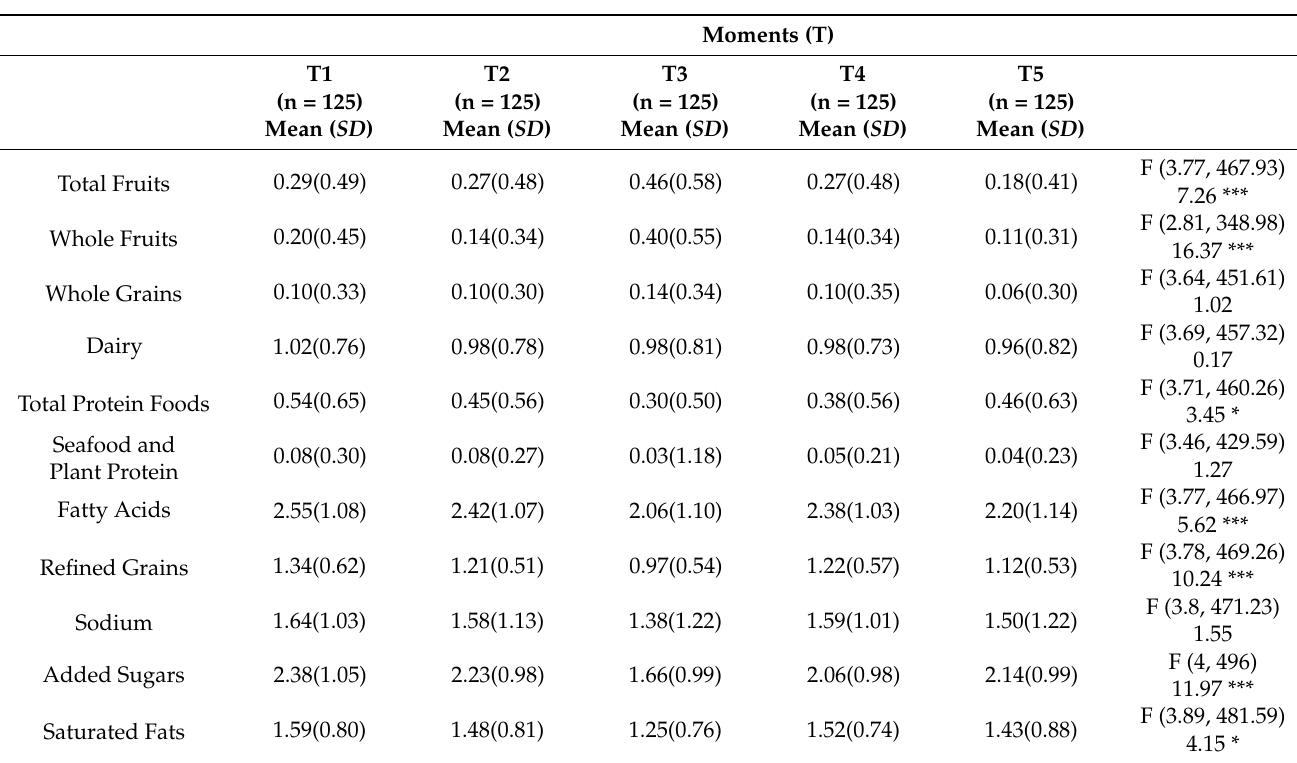
Table 5. Portions of each component consumed among moments (T1–T5), and results of the Repeated Measures ANOVA.